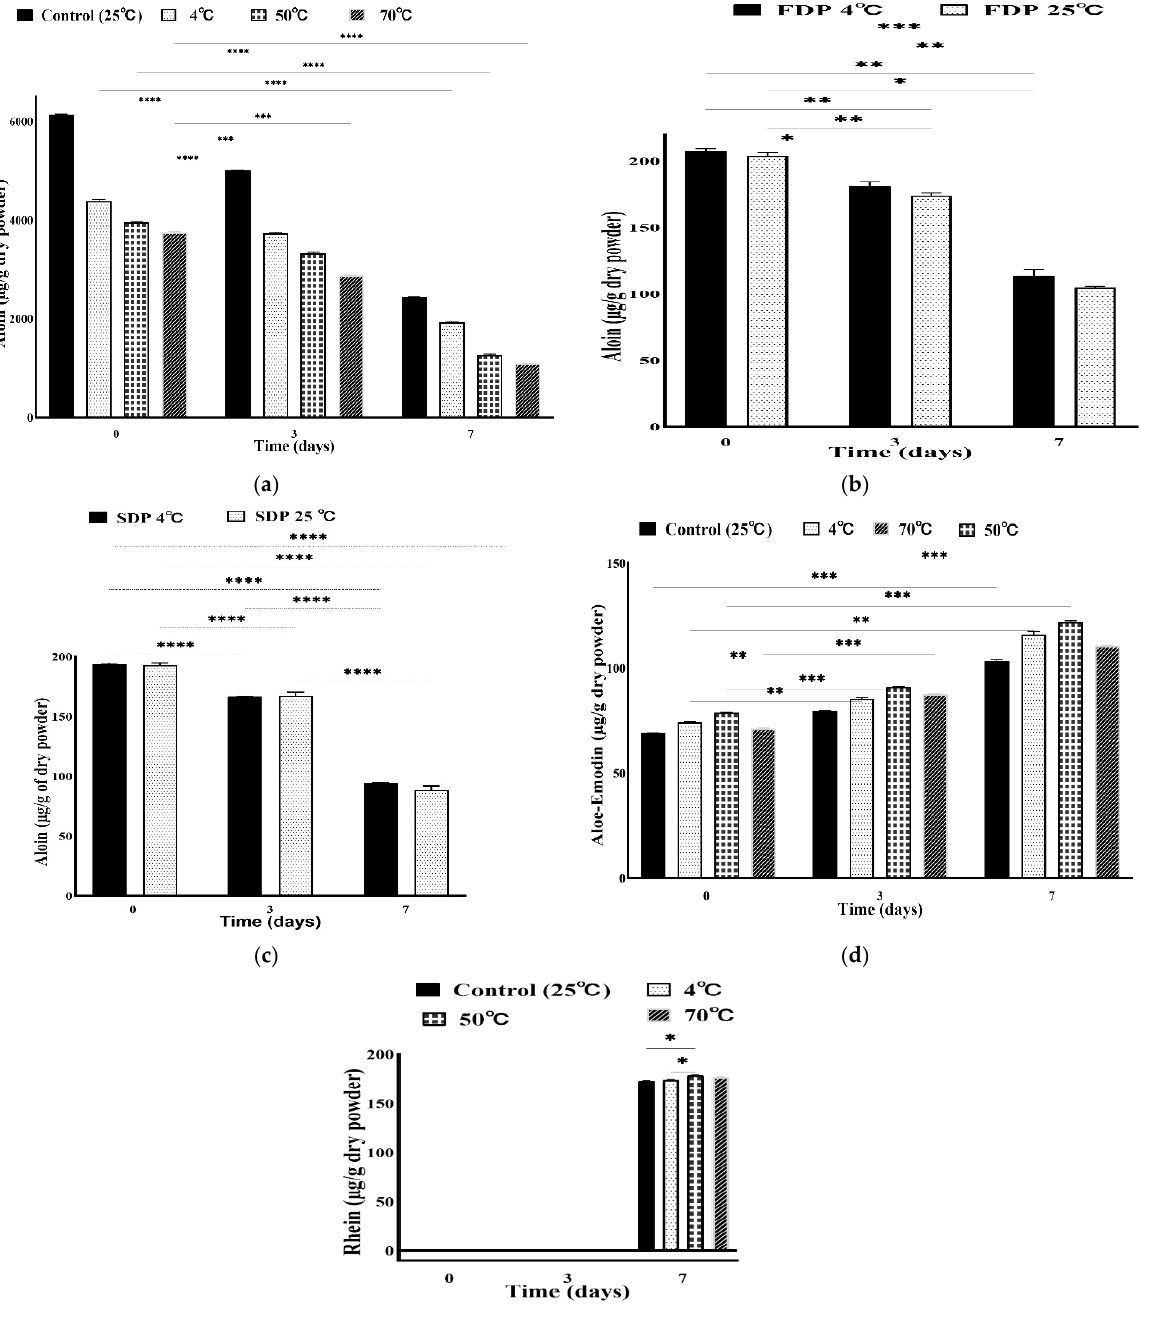
Figure 3. Plots of aloin in whole ‐ leaf Aloe vera gel ( a ), aloin in freeze ‐ dried powder of Aloe vera ( b ), aloin in spray ‐ dried powder of Aloe vera ( c ) and plots of aloe ‐ emodin ( d ) and rhein ( e ) in whole ‐ leaf Aloe vera gel, vs. time under various temperature conditions. (Values are from triplicates; the mean and standard deviation are shown. Values significantly different from control to various tempera ‐ ture treatments in a two ‐ way ANOVA with Dunnett’s test analysis indicated with asterisks: * p < 0.01, ** p < 0.001, *** p < 0.0003, **** p < 0.0001).